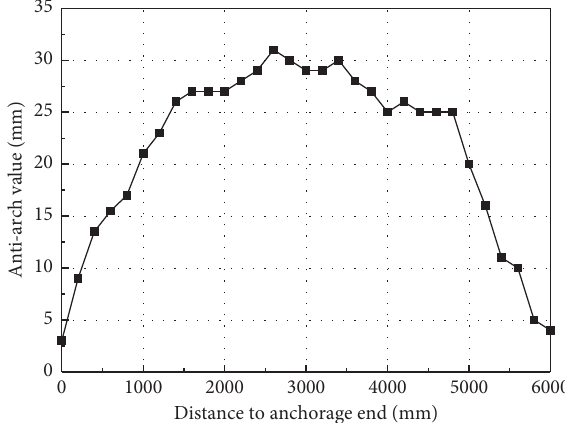
Figure 8: The antiarch value of PRPCB6 after fire.